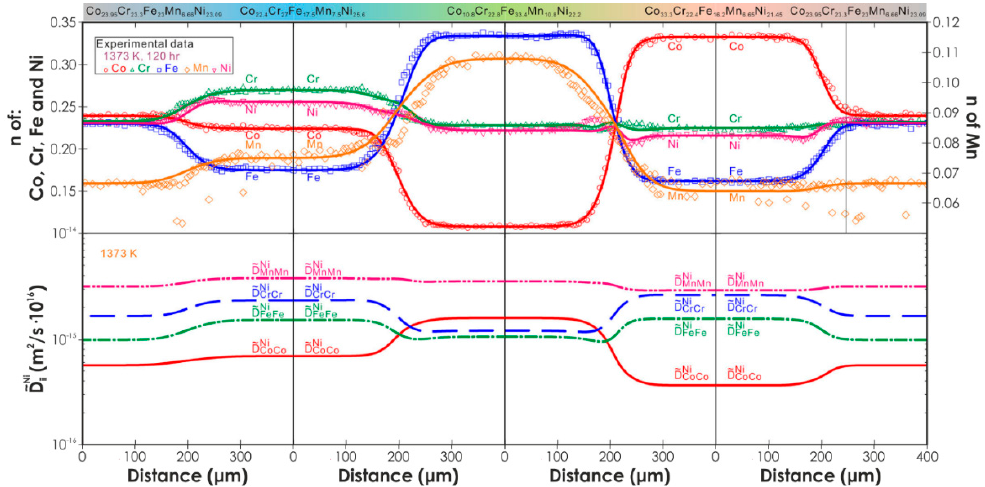
Figure 9. Composition profiles (both experimental and simulated) and the corresponding main interdiffusivities for the diffusion multiple (after [35]). Reprinted by permission from Springer Nature: Springer, Journal of the Phase Equilibrium and Diffusion, Chen, W.; Zhang, L. High-Throughput Determination of Interdiffusion Coefficients for Co-Cr-Fe-Mn-Ni High-Entropy Alloys, 2017. − 15 The authors compared the value of the obtained ˜ D Ni (0.98 − 1.98 × 10 m 2 / s at 1373 K) FeFe